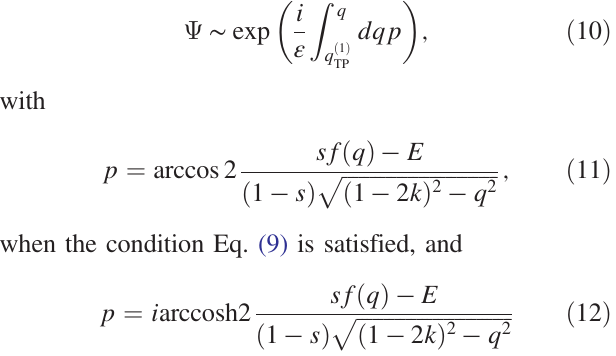
FIG. 2. The effective classical potential is shown for s ¼ 0 , the pure transverse-field case (left); s ¼ s temperature quantum phase transition point (center); and s ¼ 1 , the pure classical potential (right). Different lines (bottom to top on all plots) correspond to different values of k ¼ 0 ; … ; 0 . 5 with equal intervals. Note that in the absence of the transverse field, the states with 0 and q ≈ 0 . 467 different values of k are degenerate. Here, q min ¼ max